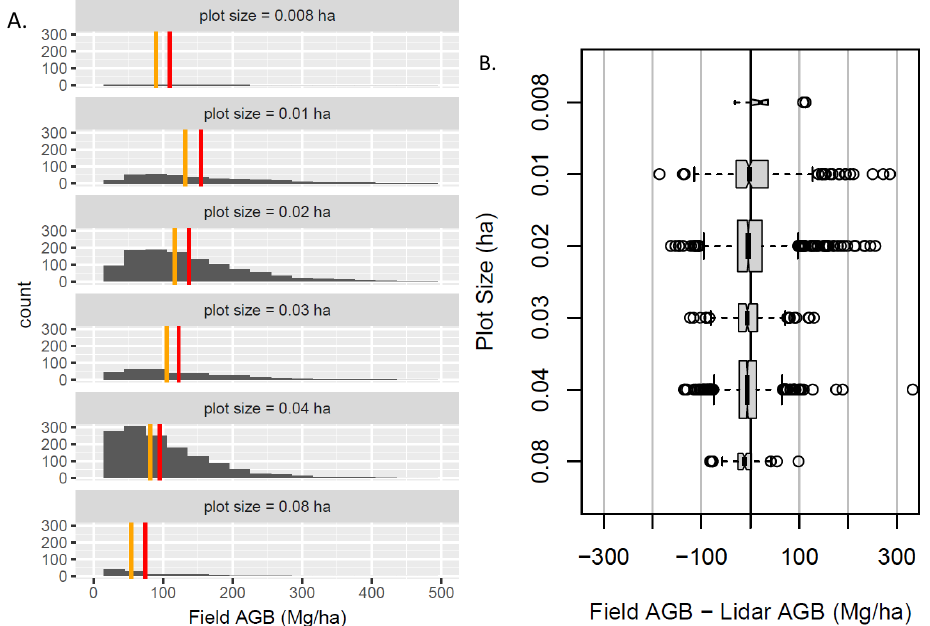
Figure 4. Distribution of AGB and trimmed median probability model disagreement by plot size: ( A ) Histogram of field-estimated AGB for each of the plot sizes. The red line is the group mean, orange is group median and ( B ) Box plot of disagreement between field-estimated and lidar-estimated AGB from the trimmed median probability model for each of the different plot sizes. Plot width is proportional to the square root of the number of observations in each group. Notches indicate a 95% confidence interval of the mean